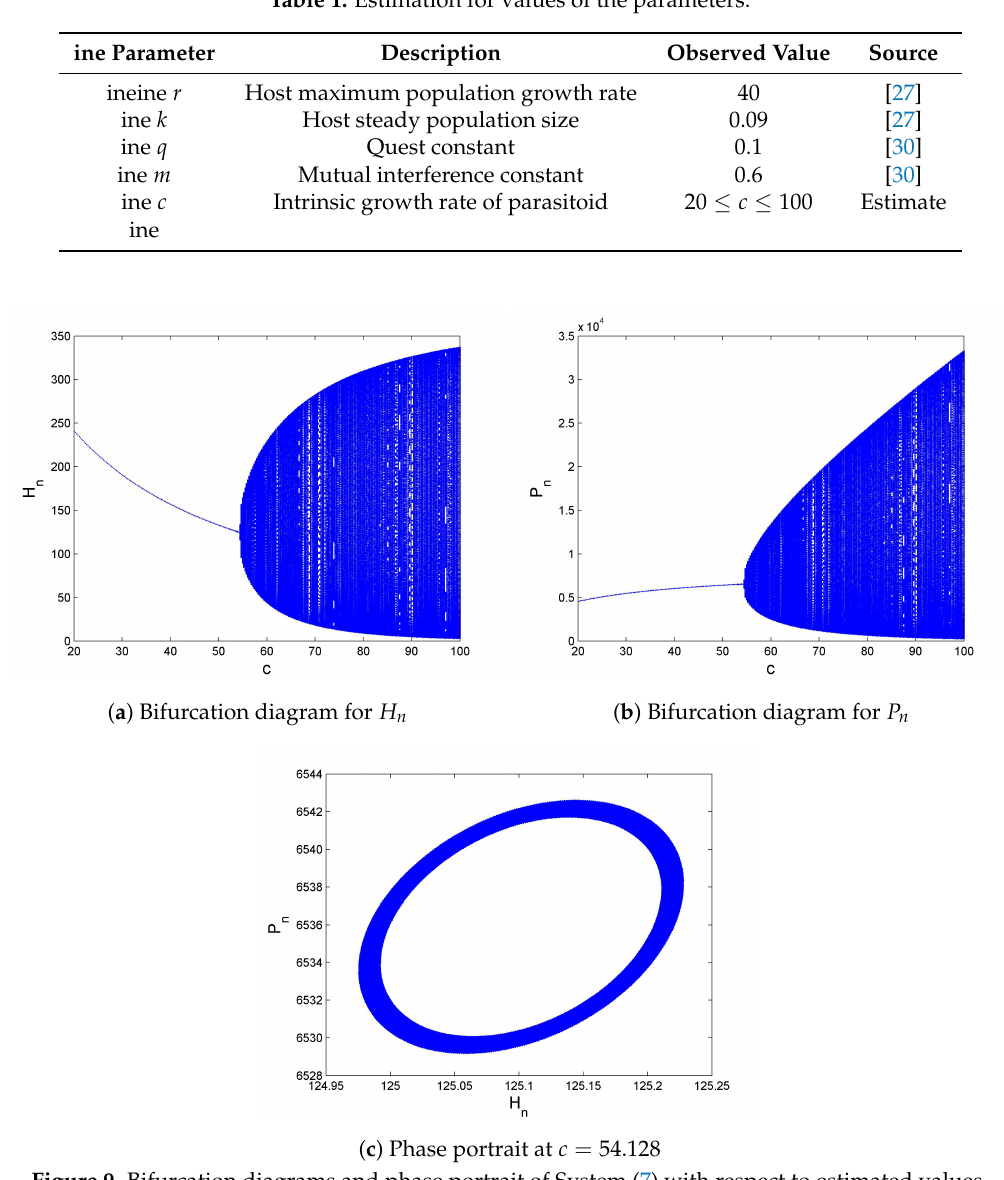
Figure 9. Bifurcation diagrams and phase portrait of System (7) with respect to estimated